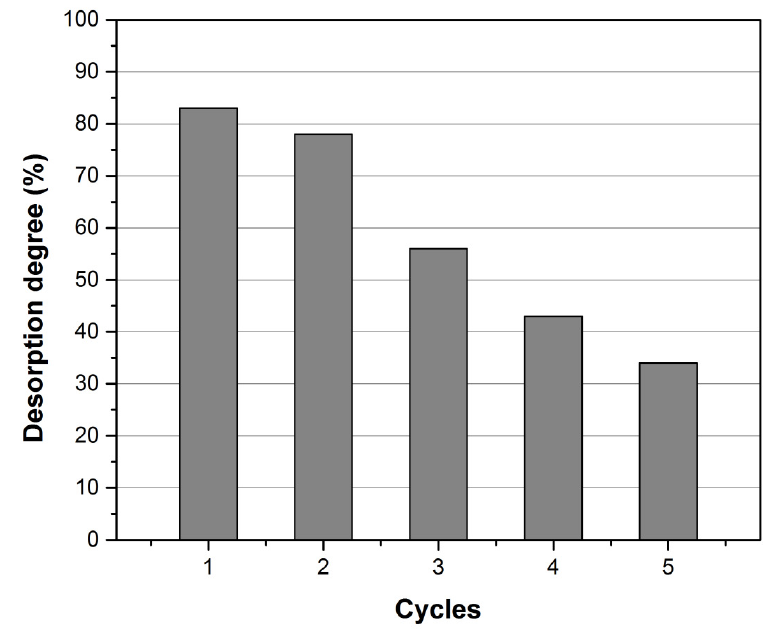
Figure 10. Comparative desorption degree of HNO 3 5%, as desorption agent, to elute Au (III) ions from XAD7-AcG adsorbent material, in consecutive cycles.